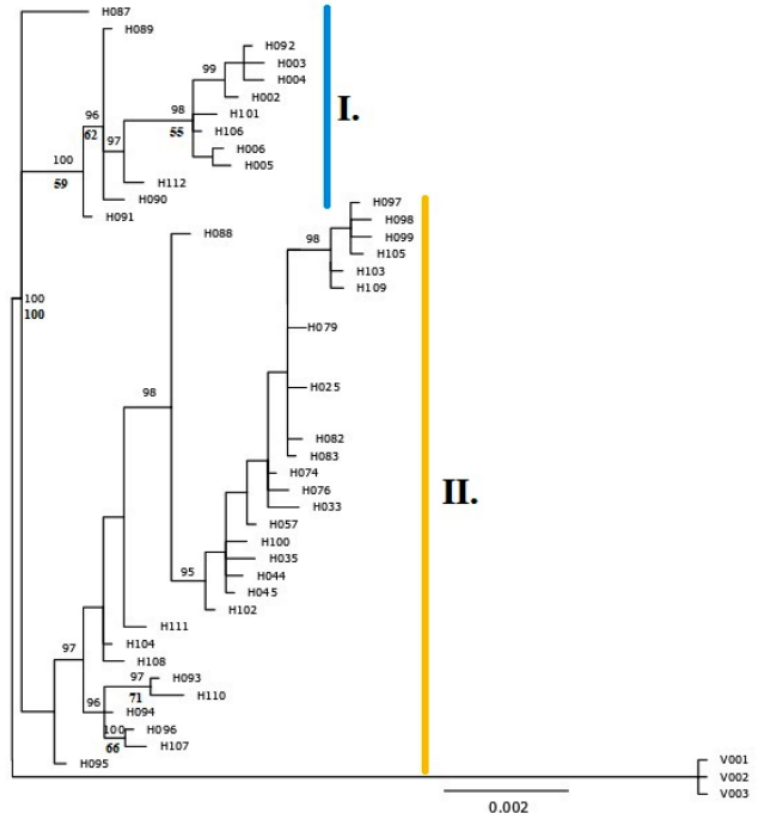
Figure 2. Phylogenetic relationships within the Alnus glutinosa s. l. in the study area estimated based on the concatenated dataset of three cpDNA spacers. Fifty per cent majority-rule consensus tree of the Bayesian phylogenetic analysis; numbers above branches indicate Bayesian posterior probabilities (in percentages; only values higher than 95% are shown), and numbers below branches, bootstrap support (in percentages; only values higher than 50% are shown) from the maximum parsimony analysis. All cpDNA halotypes were deposited in GenBank under Accession MT729389–